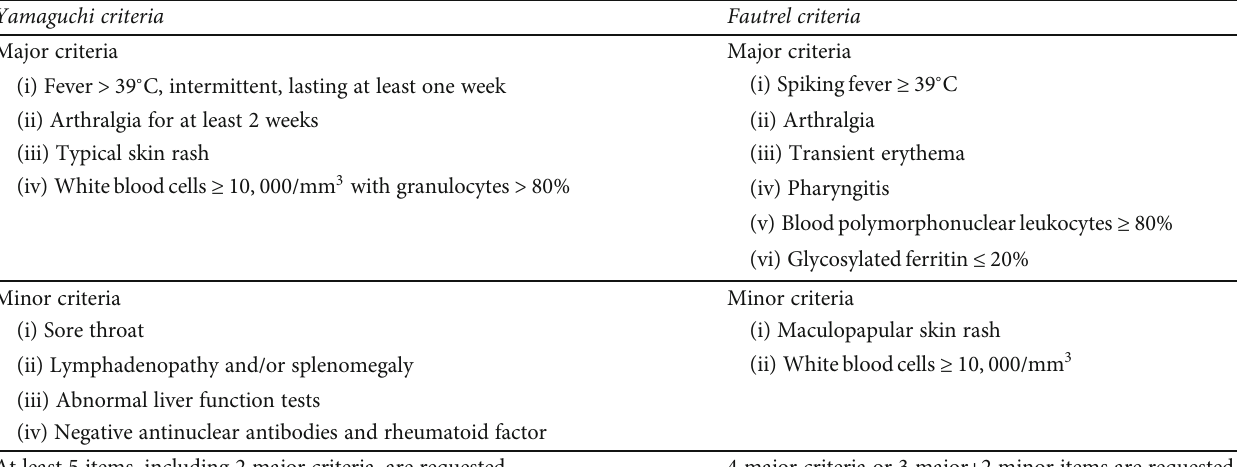
Table 3: Clinical criteria for the diagnosis of adult onset Still ’ s disease (AOSD); adapted from Yamaguchi et al. [132] and Fautrel et al. [129]. Infections, malignancies, and other rheumatologic diseases represent exclusion